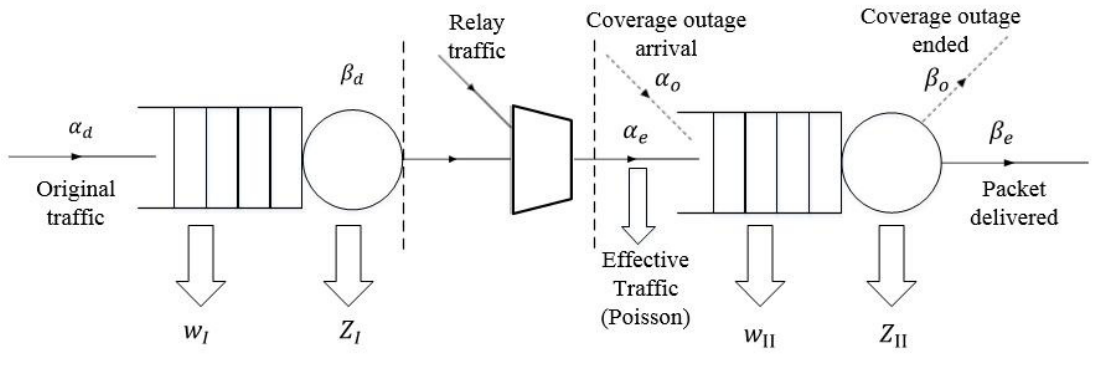
Figure 2. Queueing model representation of the hybrid ad hoc